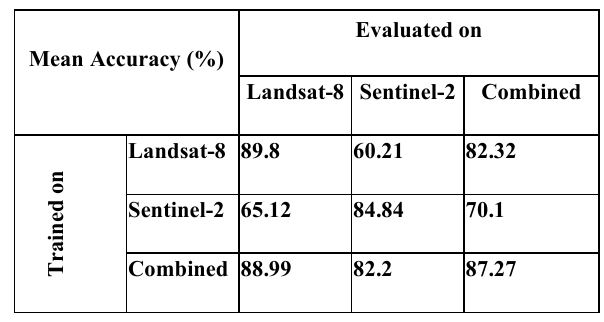
Table 3: Mean accuracy values on different types of datasets.